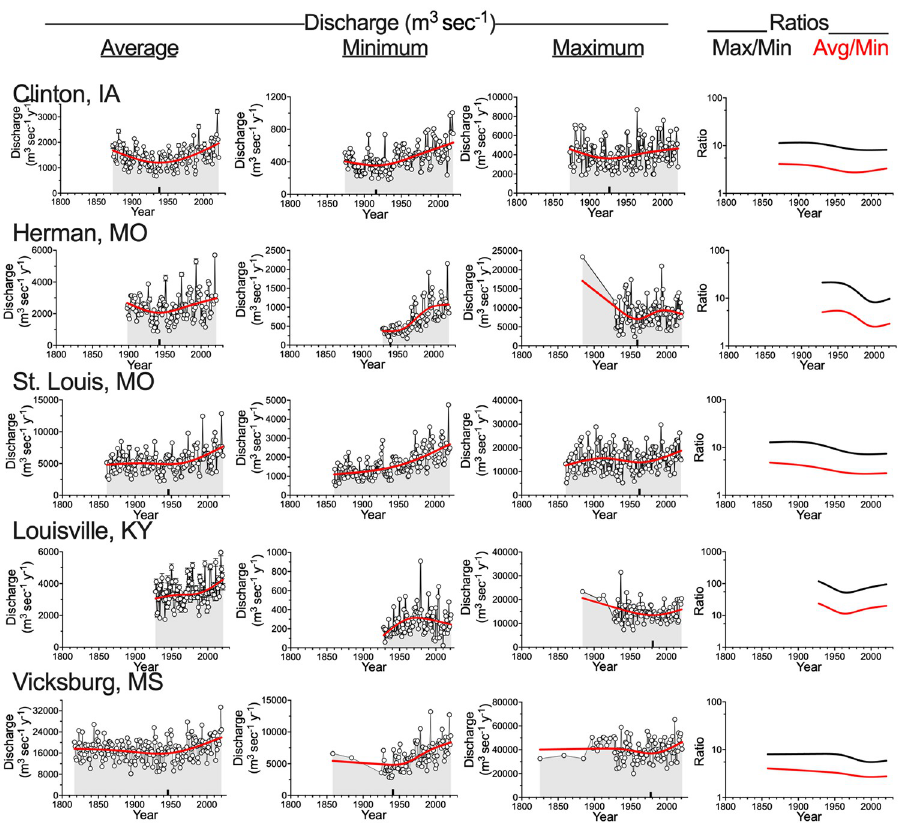
Fig 3. The annual average, minimum, and maximum discharge (m 3 sec -1 ) and the ratios of the maximum/ minimum (red line) and average/minimum (black line) at the five stations in the Mississippi River watershed. Clinton, IA, St. Louis, MO, and Vicksburg, MS, are on the main stem of the Mississippi River; Herman, MO, is on the Missouri River, and Louisville, KY, is on the Ohio River. The inflection point where a decrease becomes an increase is indicated by the small black bar on the horizontal